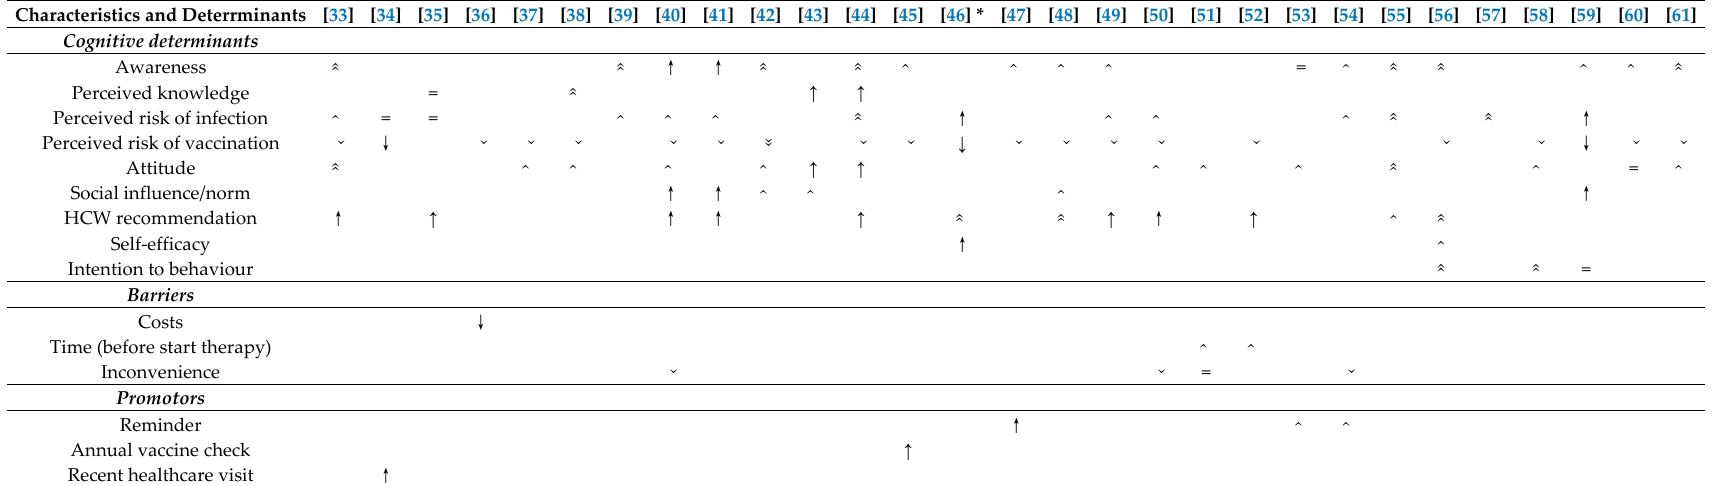
Table 3. Cont. Vaccines 2020 , 8 , x FOR PEER REVIEW 4 of 6